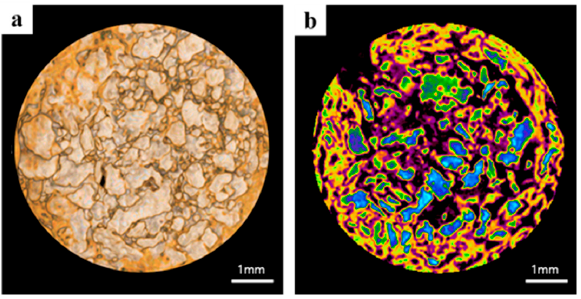
Figure 3. In micro-computed tomography analysis, images of a region of interest: ( a ) reconstructed image; and ( b ) color images of bone graft material and new bone.